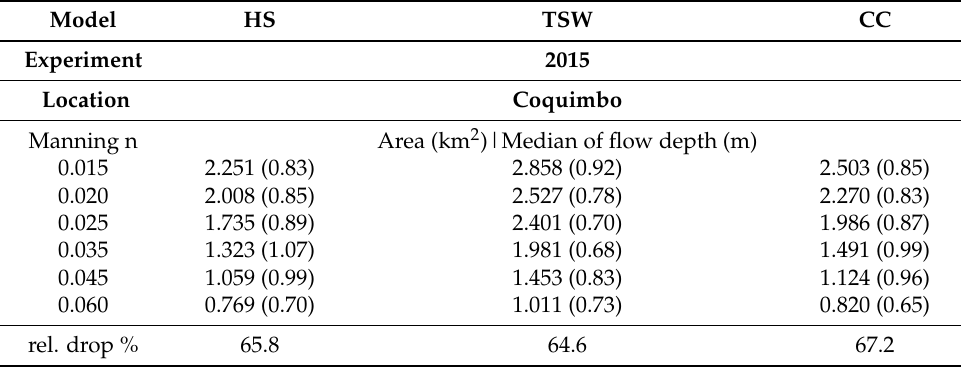
Table 5. Inundation areas obtained for the different Manning values in Experiment 2015. The relative drop in estimates refer to the difference between the largest and the smallest values. Inside the brackets, the median values for inundation are shown (in metres). In addition to the median values, other statistical parameters are shown in Table S1 in the Supplementary